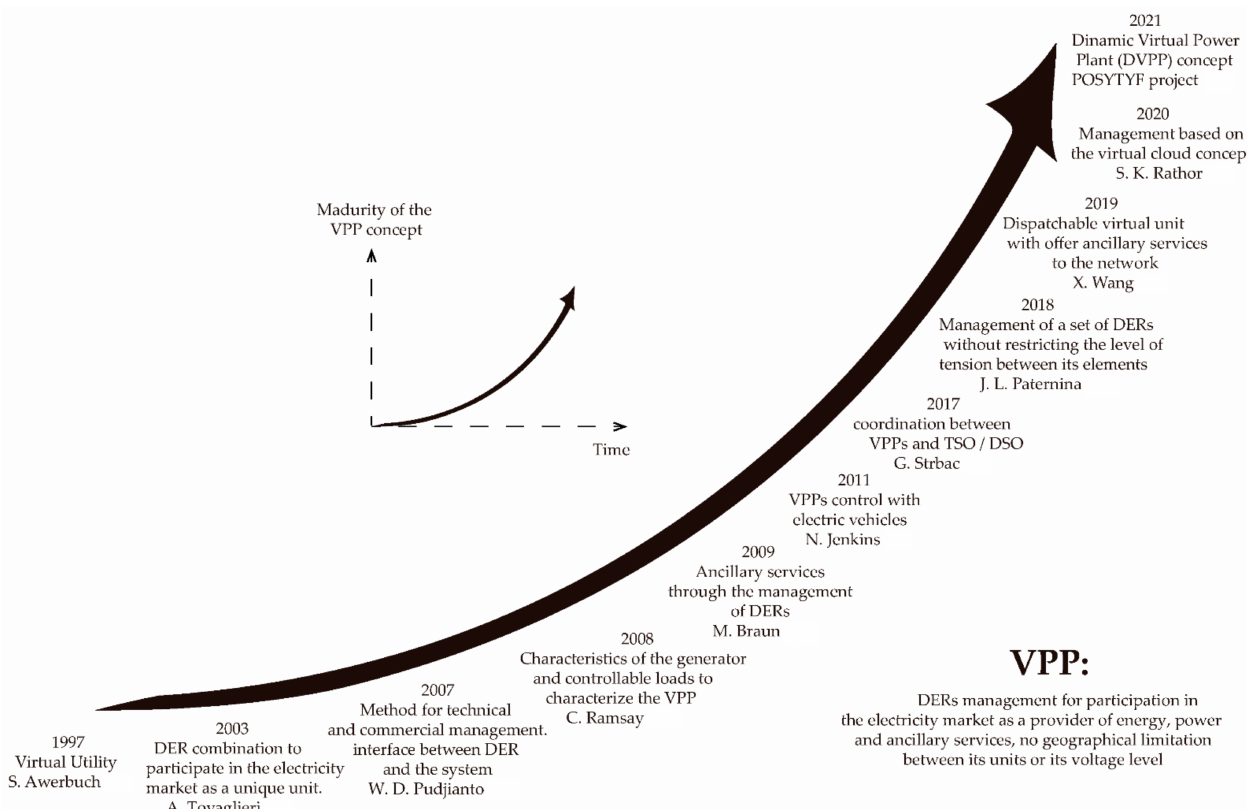
Figure 2. Time evolution of the concept and scope of VPP. S. Awerbuch [35], A. Tovaglieri [36], W.